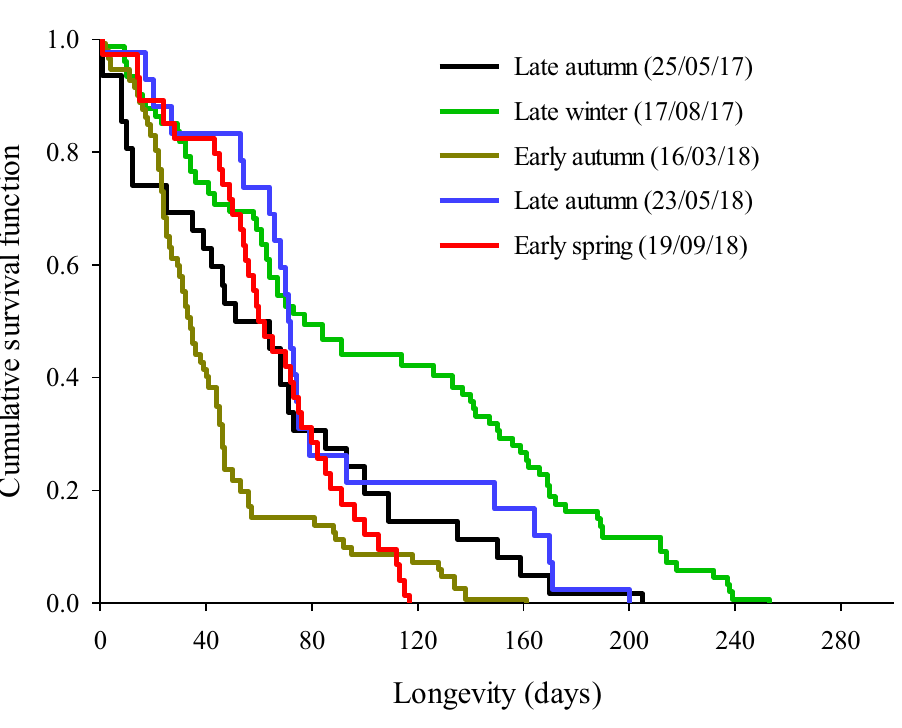
Figure 1. Cumulative survival curves of five cohorts of adult male Bactrocera tryoni that emerged in the laboratory from field infested fruit (= reference cohorts) collected during different seasons in 2017–18 from a site in subtropical Australia. In the laboratory flies were held at 27 °C constant temperature and had ad libitum access to water and